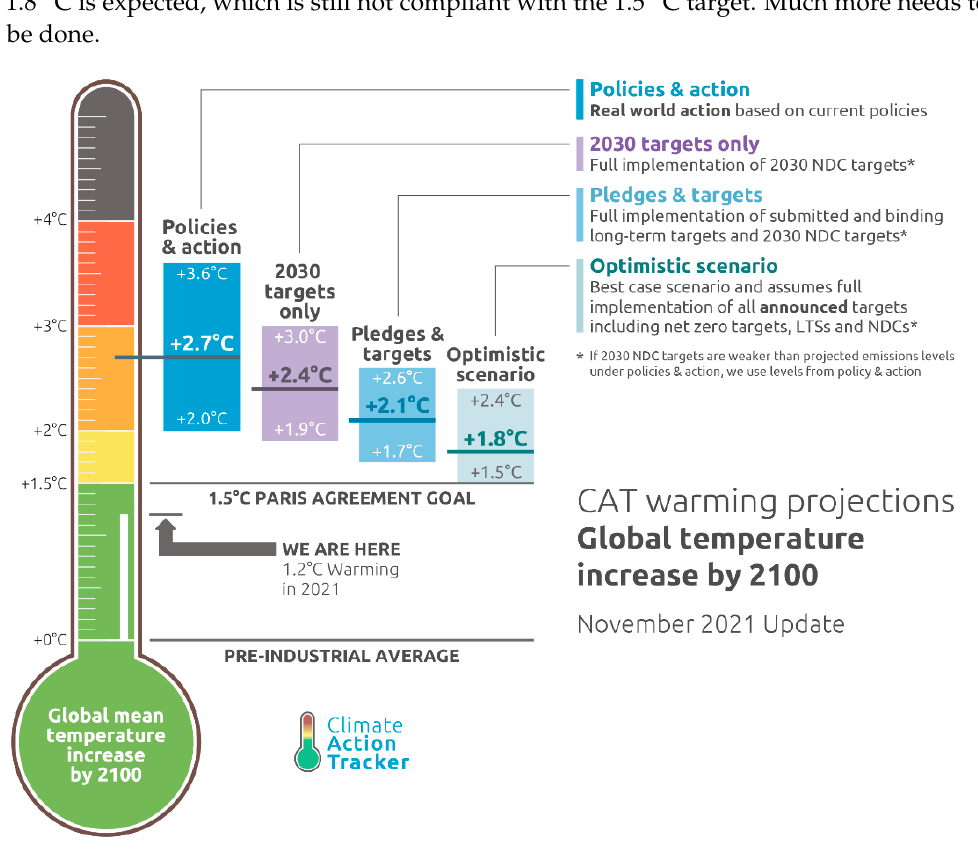
Figure 1. Climate Action Tracker (CAT) warming projections by 2100 (reprinted with permission from Ref. [2]. 2021, Climate Analytics and NewClimate Institute).